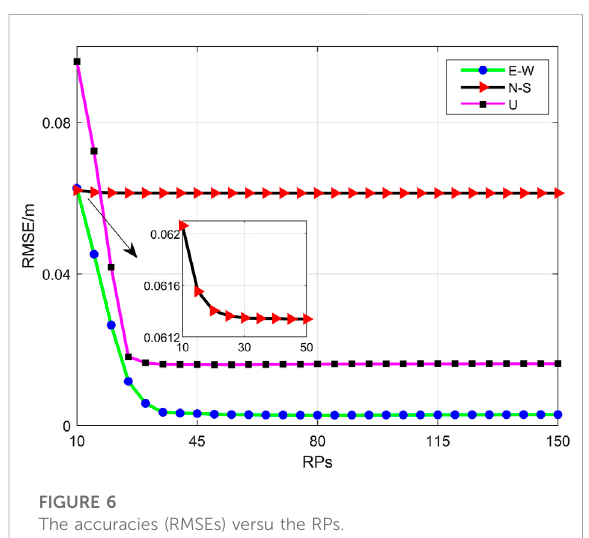
The accuracies (RMSEs) versu the